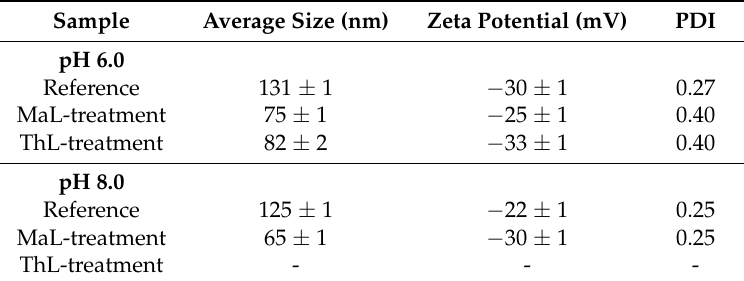
Table 1. Characterization of CLPs prepared from laccase-treated lignin.